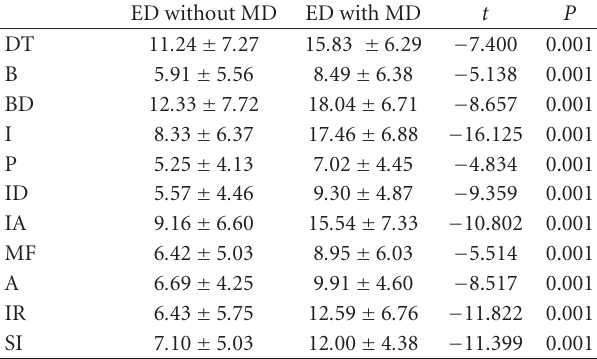
Table 4: Eating Disorder Inventory-2 (EDI-2).